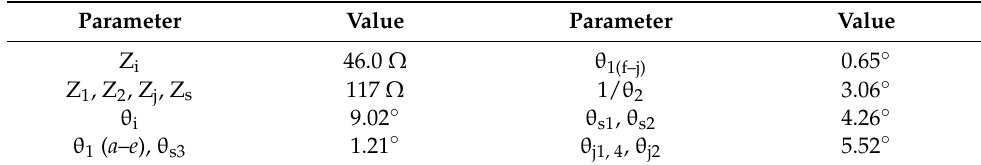
Table 1. Calculated electrical parameters.